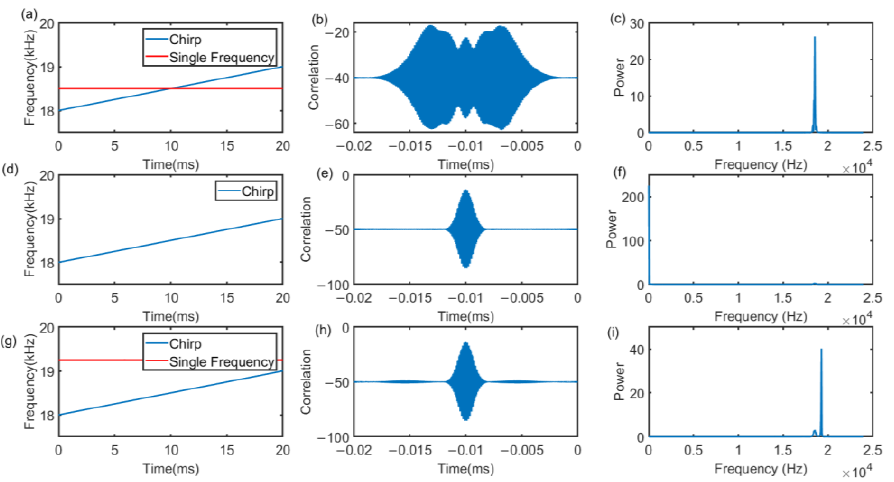
Figure 11. Time-frequency domain analysis of different signals. ( a , d , g ) is the time-frequency domain of the designed signal. ( b , e , h ) is the correlation results with Chirp of 18 kHz – 19 kHz. ( c , f , i ) are the frequency spectrogram, respectively.